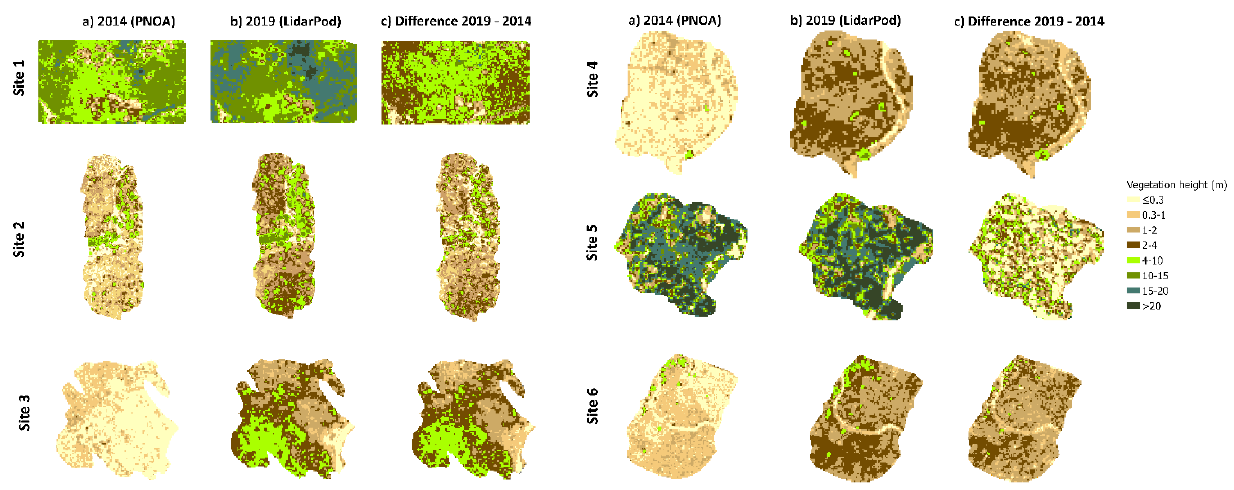
Figure 7. Canopy height models (CHMs) from: ( a ) low-density LiDAR (2014), ( b ) high-density LiDAR (2019) and ( c ) their height differences for each site using the best classification filter: In sites 1, 4 and 6: TIN densification algorithm with Siose Forest settings (SF); in site 2, the progressive morphological filter (PMF) and in sites 3 and 5, the TIN densification algorithm with default settings (DEF).